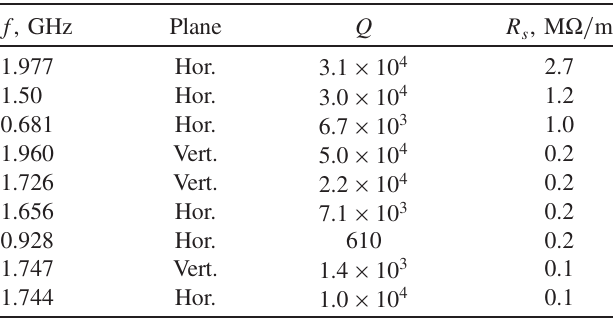
TABLE IV. DQW HOMs with the largest transverse shunt impedance. Simulation data from HL-LHC impedance model as of Oct. 2016.